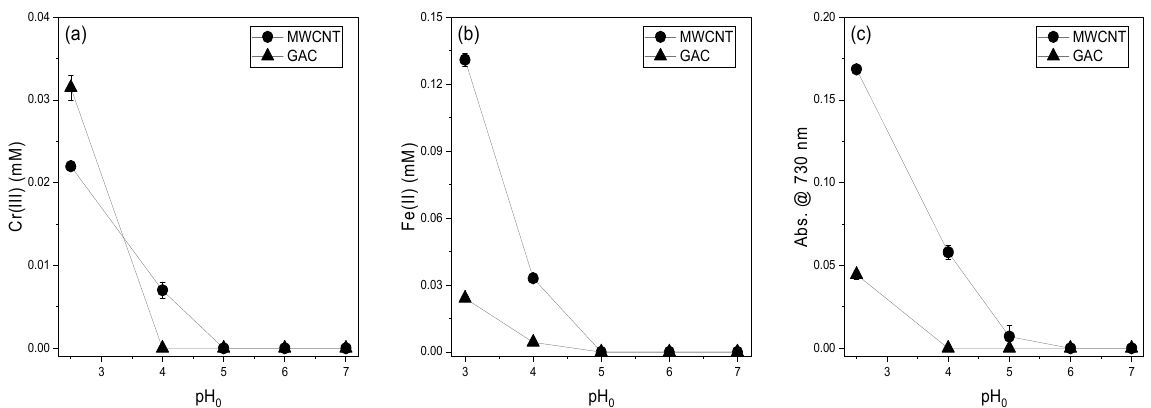
Figure 5. Reduction of ( a ) Cr(VI), ( b ) Fe(III) and ( c ) PMo 12 O 403 − at different initial pH conditions ([Cr(VI)] o = [Fe(III)] o = [PMo 12 O 403 − ] o = 0.1 mM, [MWCNT-Comocat] o = [GAC] o = 2.0 g/L, [pH o = 2.5-7], anaerobic condition, [reaction time = 5 min for Fe(III), 60 min for Cr(VI), 120 min for PMo 12 O 403 − ]).